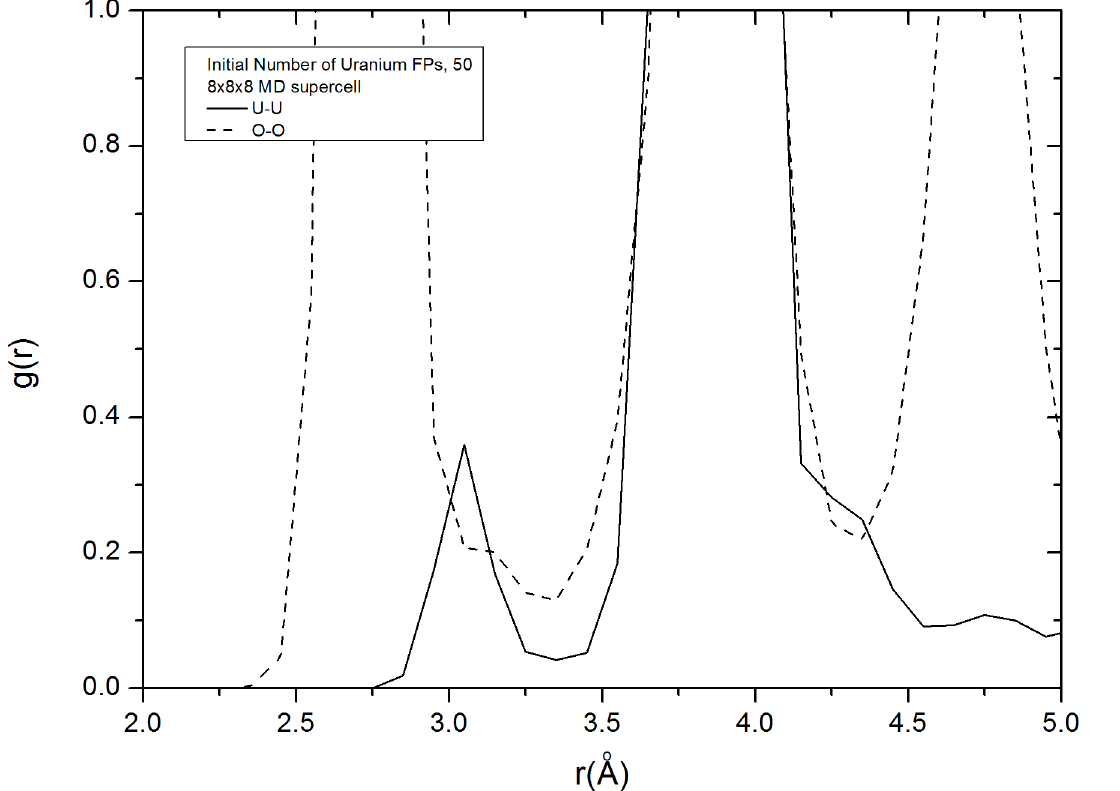
Fig 9. Radial distribution functions. g uu ( r ) and g oo ( r ) of UO 2 with 50 uranium IFPs in a 8×8×8 MD supercell.